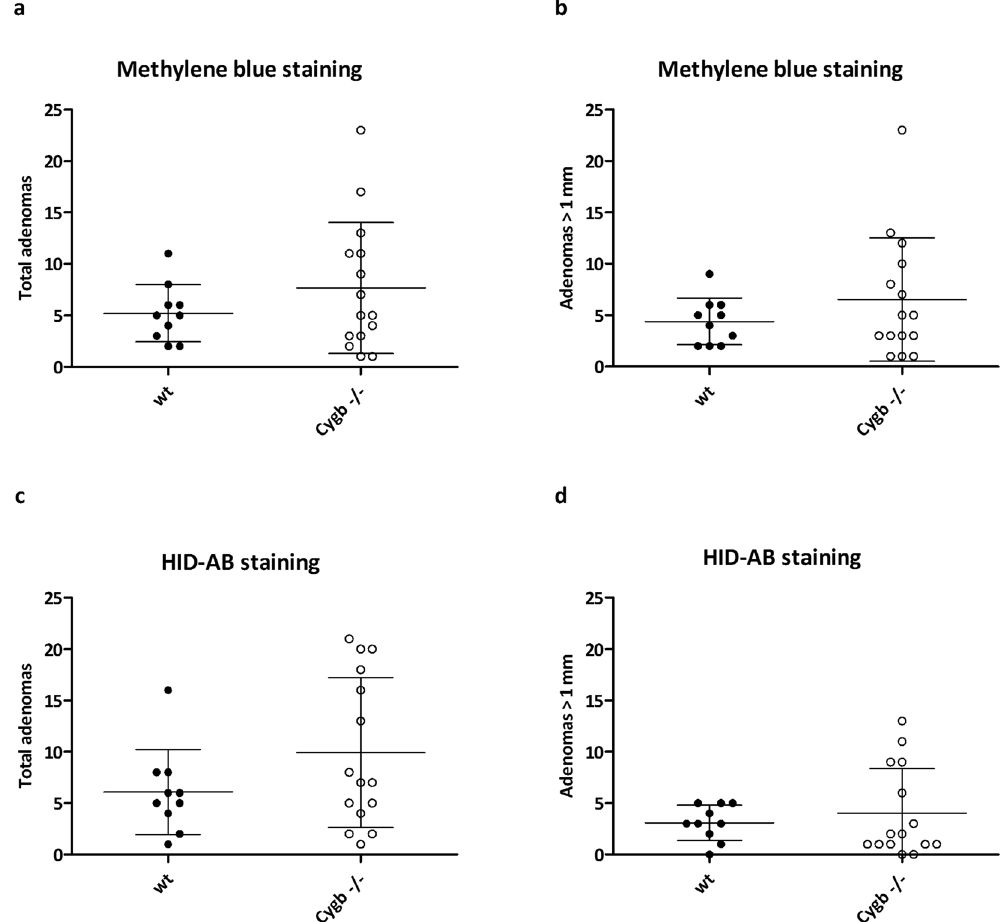
Figure 7. Early adenomas in Cygb-deficient mice. Colons were pinned onto a plate, stained with methylene blue, and then total adenomas ( a ) and adenomas > 1 mm ( b ) were counted under a stereomicroscope. After this procedure, colons were stained with HID-AB, and both total adenomas ( c ) and adenomas > 1 mm ( d ) were counted again. Each dot represents an individual mouse. The results are presented as the mean ± SD. No significant differences were found between WT and Cygb − / − mice. The experiment was initiated by AOM injection followed by one cycle of 3% DSS in week 2 for seven days. All mice were euthanized at the end of week 5, three weeks after the end of the DSS